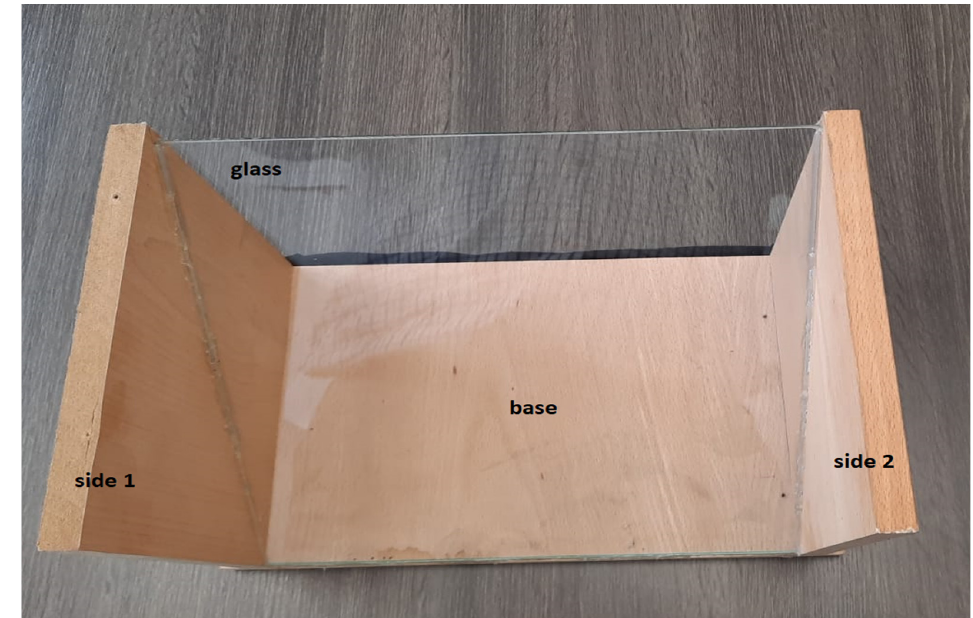
Figure 3. The experimental setup for hologram.